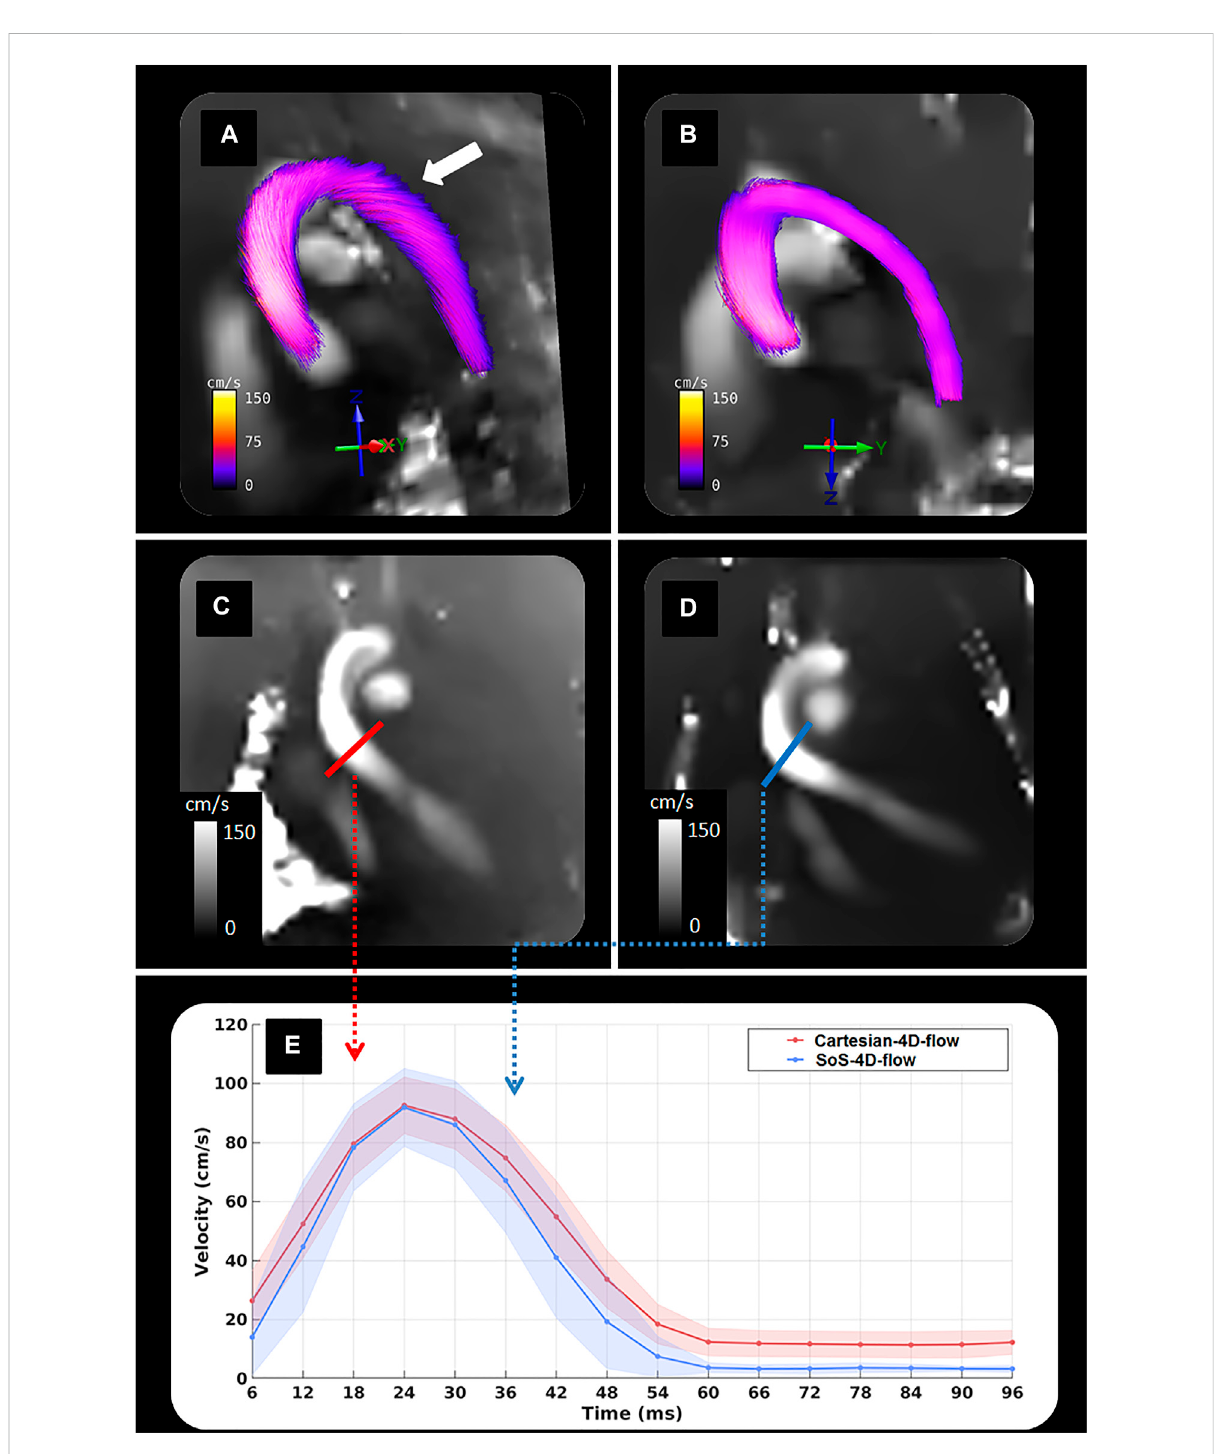
FIGURE 6 Representative fi gureshowing (A) Streamlinevisualizationofan in-vivo dataobtainedbyCartesia-4D- fl ow; (B) Streamlinevisualizationofan in- vivo data obtained by SoS-4D- fl ow; (C) A velocity map of an in-vivo data acquired by Cartesian-4D- fl ow; (D) A velocity map of an in-vivo data measured by SoS-4D- fl ow; (E) Velocity-time curves at the cross-section of the distal ascending aorta obtained by the k 0 -navigated SoS-4D- fl ow and the prospectively-triggered Cartesian-4D- fl ow technique. Please note that the strong background velocity in the Cartesian-4D- fl ow data has in fl uenced the streamline orientation in aorta (solid white arrow), while the streamline quality is well-preserved in the SoS-4D- fl ow